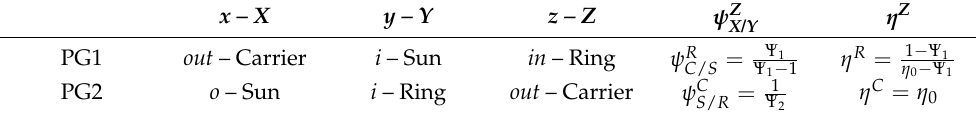
Table 3. PGs reference notation, fixed-Z speed ratios, and fixed-Z efficiency [35,36].